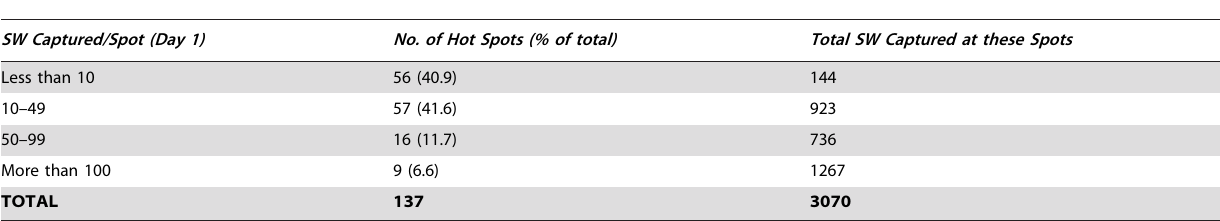
Table 2. Distrubution of SW enumerated based on SW volume at each hot spot.